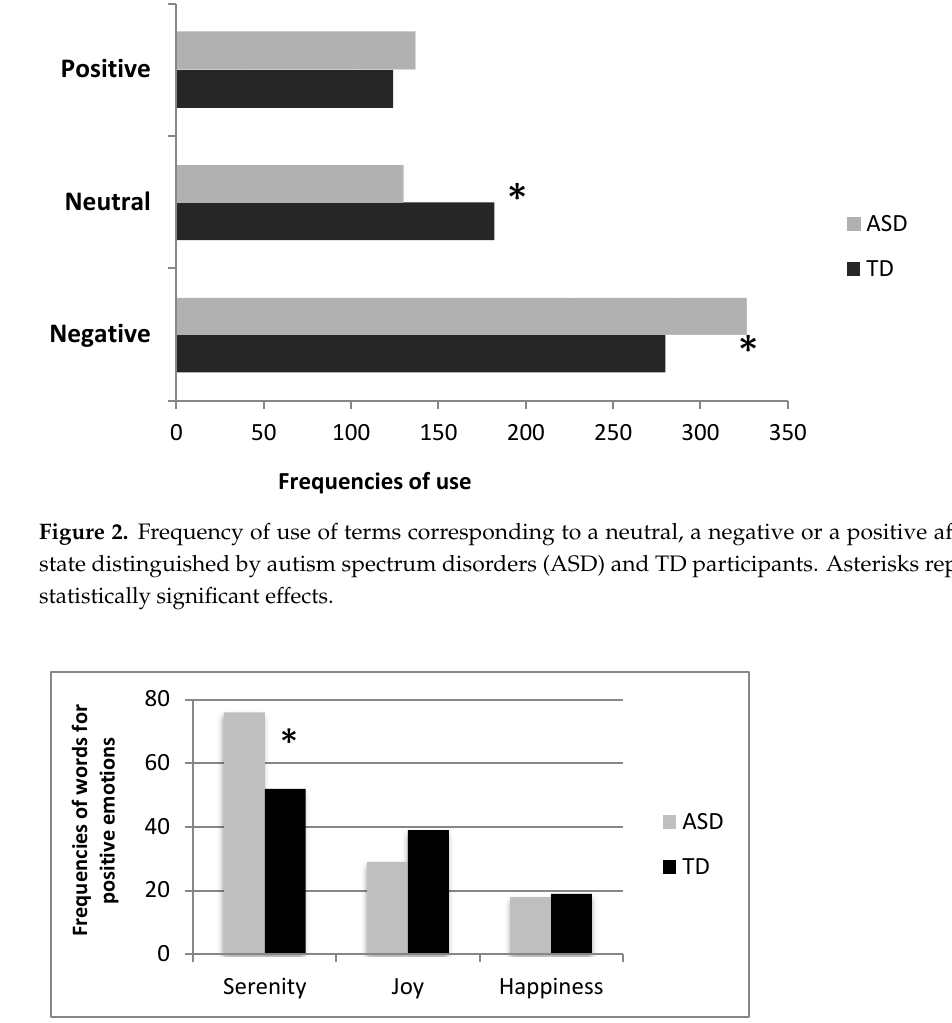
Figure 5. Frequency of use of terms corresponding to neutral emotions distinguished by ASD and TD participants. 3.1.3. Missing Values Globally the number of missing values summed up to 110 (Figure 6). As expected, ASD group found more difficult to spontaneously associate an emotion to a stimulus (28 vs. 82 missing values for TD and ASD, respectively), but only when the stimulus was a body (bodies: 16 vs. 64 missing values for TD and ASD, respectively; heads: 12 vs. 18 for TD and ASD, respectively, χ 2 (1) = 4.59, p = 0.03).